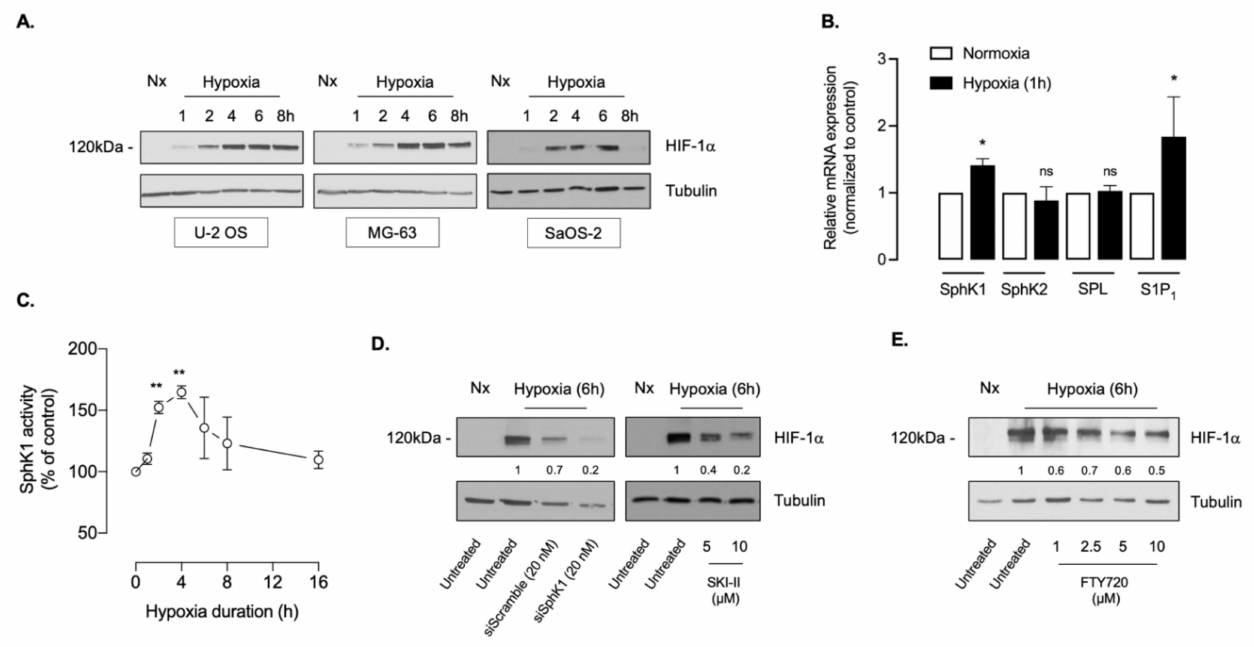
Figure 1. SphK1 inhibition by pharmacological inhibitors or RNA-silencing prevents HIF-1 α ac- cumulation in osteosarcoma. ( A ), human osteosarcoma U-2 OS, MG-63 and SaOS-2 cancer cells were incubated under normoxia or hypoxia up to 8 h. Cells were lysed and HIF-1 α expression was analyzed by immunoblotting with an anti-HIF-1 α antibody. Similar results were obtained in three independent experiments. ( B ), relative mRNA expression of SphK1, SphK2, S1P lyase (SPL) and S1P1 was measured in normoxic (Nx) and hypoxic U-2 OS cells. Columns; mean of at least three independent experiments, SEM. *, p < 0.05; n.s., not significant. ( C ), U-2 OS cells were incubated under hypoxia for the indicated times. Cell lysates were tested for SphK1 activity. Points; mean of five independent experiments, SEM. **, p < 0.01. Basal SphK1 activity was 290 ± 18 pmol/mg/min. ( D ), HIF-1 α expression was analyzed on U-2 OS cells treated with the indicated concentrations of SKI-II (left) or with 20 nmol/L siSphK1 or scrambled siRNA. Similar results were obtained in three independent experiments. ( E ), U-2 OS cells were treated with the indicated concentrations of FTY720 and incubated under hypoxia for 6 h. Cell lysates were assayed for HIF-1 α expression, including untreated normoxic cells (Nx). Similar results were obtained in three independent experiments. The uncropped Western blots have been shown in Figures